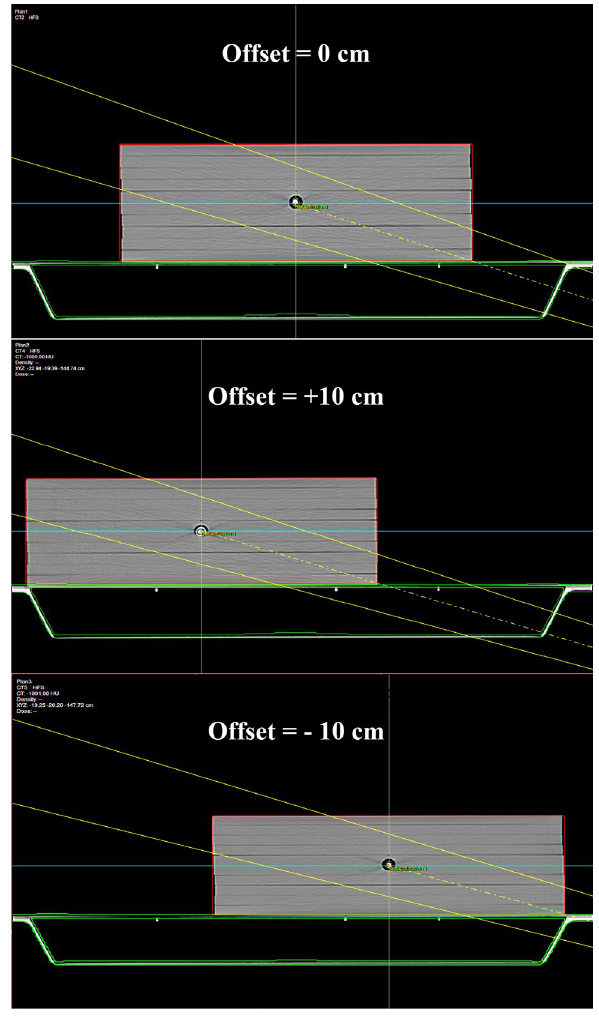
Figure 2. Diagram of solid water phantom at different positions of treatment couch, offset = 0 cm, offset = + 10 cm, offset = − 10 cm, respectively.